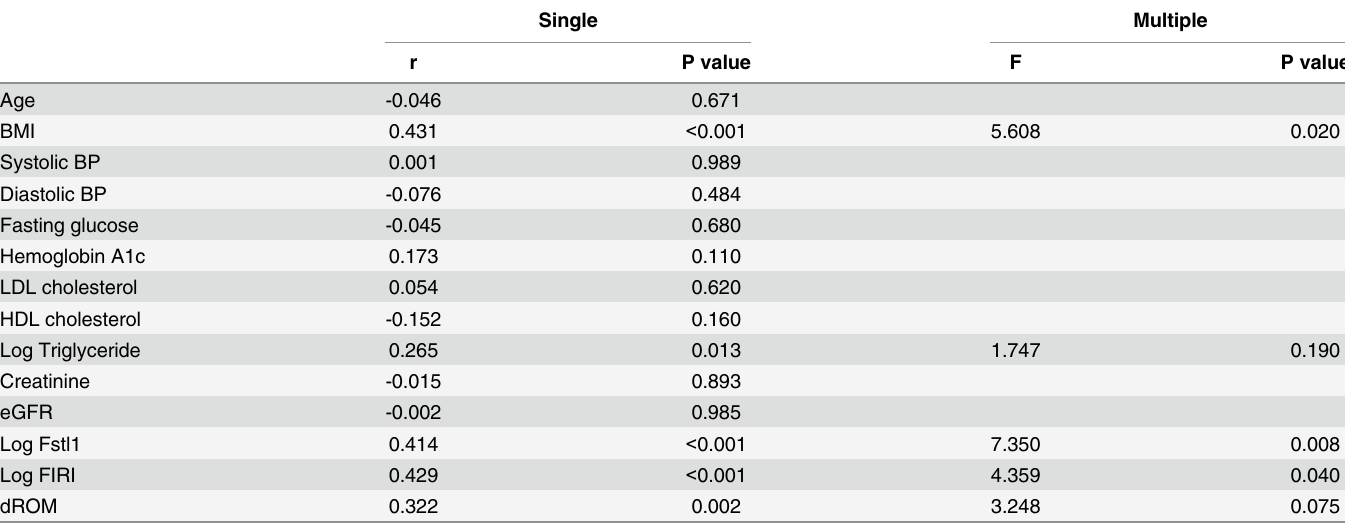
Table 3. Correlation with Log hsCRP levels.